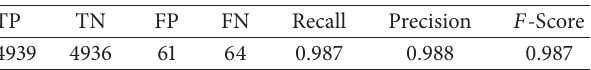
Table 5: Performance for ANN